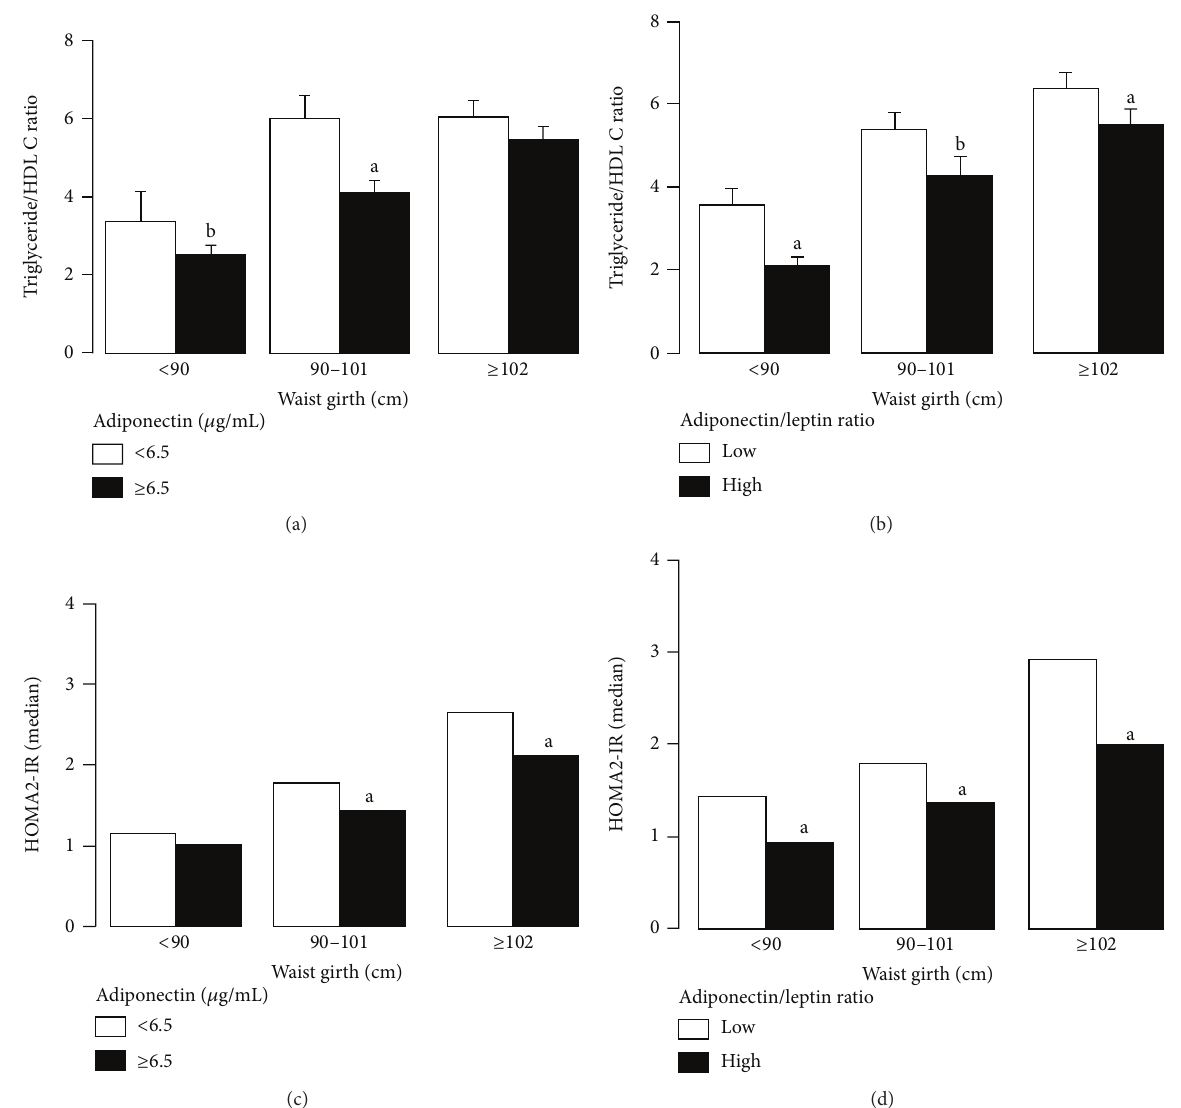
Figure 3: Ratio of triglyceride to HDL cholesterol (C) is lower in nonobese ( b 𝑃 < .05 ) and overweight ( a 𝑃 < .02 ) men who have a high level of plasma adiponectin (a). In contrast, the ratio of plasma triglyceride to HDL C is lower in nonobese, overweight, and obese subjects with a high ratio of adiponectin/leptin compared to those with a low ratio of adiponectin to leptin (b). HOMA2-IR levels are significantly higher ( a 𝑃 < .02 ) in overweight and obese men with a high level of adiponectin compared with those with a low level of adiponectin (c). However, the HOMA2-IR levels are significantly lower in nonobese, overweight, and obese men who have a high ratio of adiponectin to leptin compared with those that have a low ratio